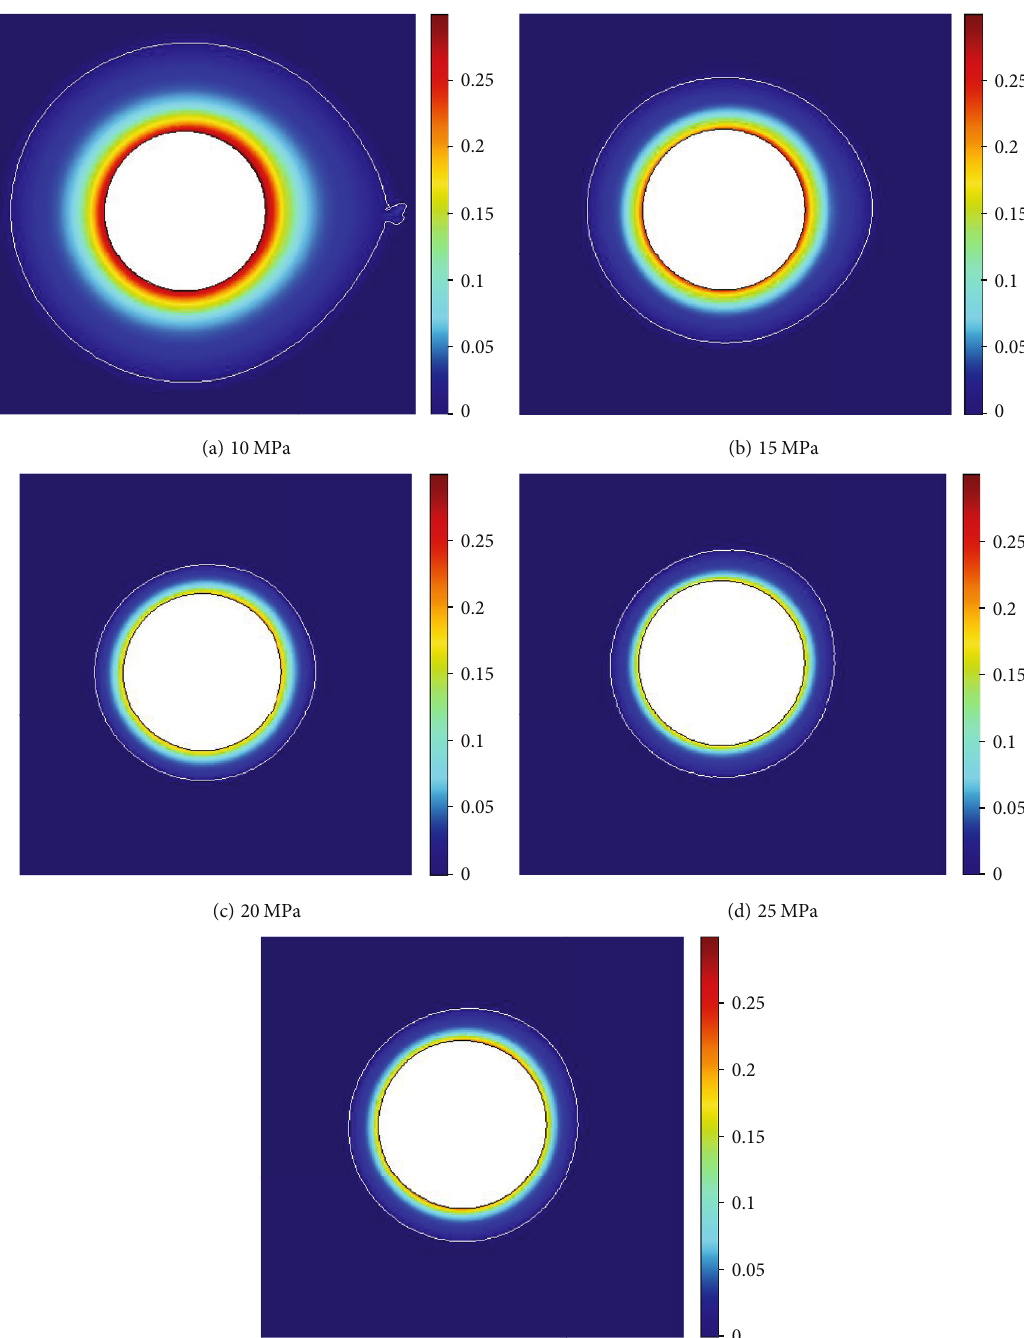
Figure 10: Distribution of surrounding rock damage after excavation under di ff erent